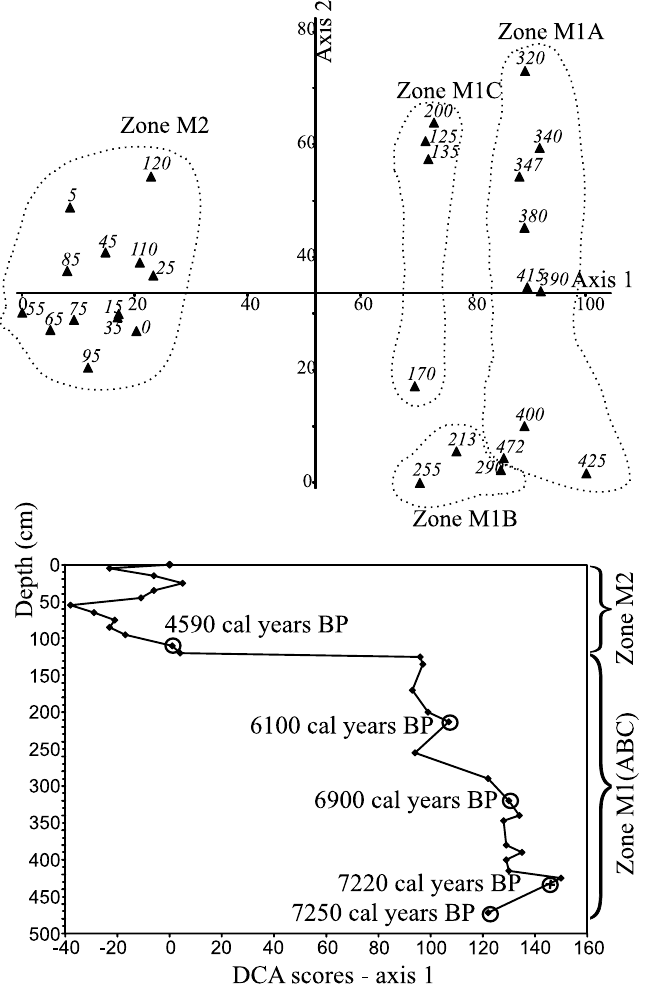
Fig. 4 – DCA scores from Lake Márcio. Top graph shows axis 1 vs. axis 2. Samples are grouped according to zones interpreted from pollen diagrams. Bottom graph displays resulting DCA scores of axis 1 plotted vs. depth (cm) showing a strong polarization of samples into two main groups representing zones M1 (ABC) and